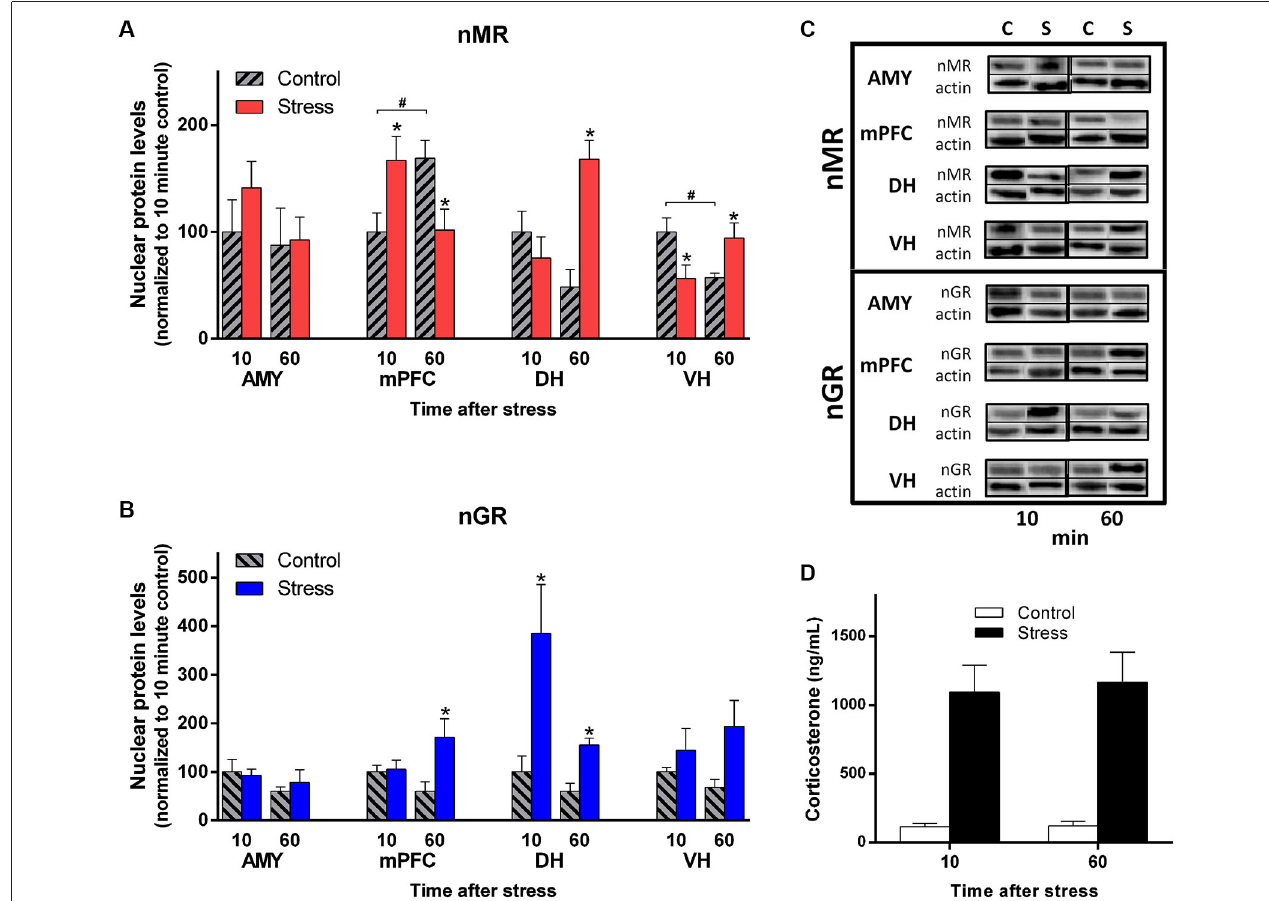
the control groups at 10 vs. 60 min. (C) Western blots of nMR and nGR levels in each brain region sampled 10 and 60 min after EP stress and in control conditions. For each timepoint, the column labels denote “Control” (“C”) and “Stress” (“S”). Upper immunoblots illustrate GR (95 kDa) or MR (102 kDa), and lower immunoblots illustrate actin (42 kDa). (D) Plasma corticosterone levels from trunk blood sampled 10 and 60 min after EP stress. Error bars denote standard error of the